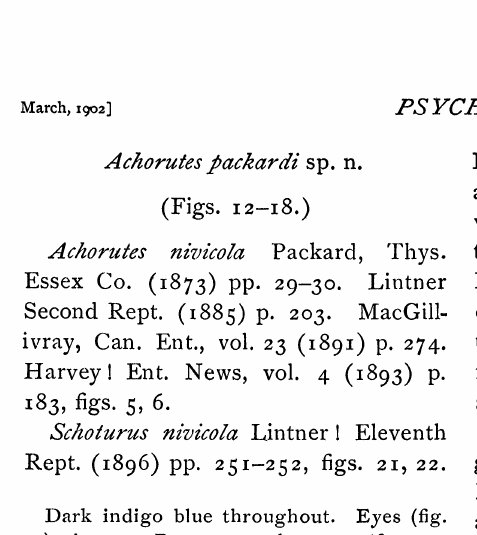
Dark indigo blue throughout. Eyes (fig. 12) sixteen. Post-antennal organs (figs. 13, 5 8:7: io basal segment globose, second and third slightly expanding, fourth subcy- lindrical with rounded apex. Body subcy- lindrical. Superior claws (fig. i5) broad, almost straight, untoothed; inferior claws of hind feet two fifths as long as the superiors, slender, lanceolate, acuminate of the remain- ing feet, one fourth as long, small; tenent hair stout, exceeding the large claw, apex bent. Manubrium as long as the rest of the furcula; dentes (fig. I6) one sixth as long, oblong, distally rounded, terminating in an upturned tooth. Anal spines (fig. I7) two, three fifths as long as a superior claw, stout, feebly curved, erect; upon contiguous papil- lae. Clothing (fig. I8) of many stout curving serrate setae of moderate length and fewer long erect capitate setae, more or less